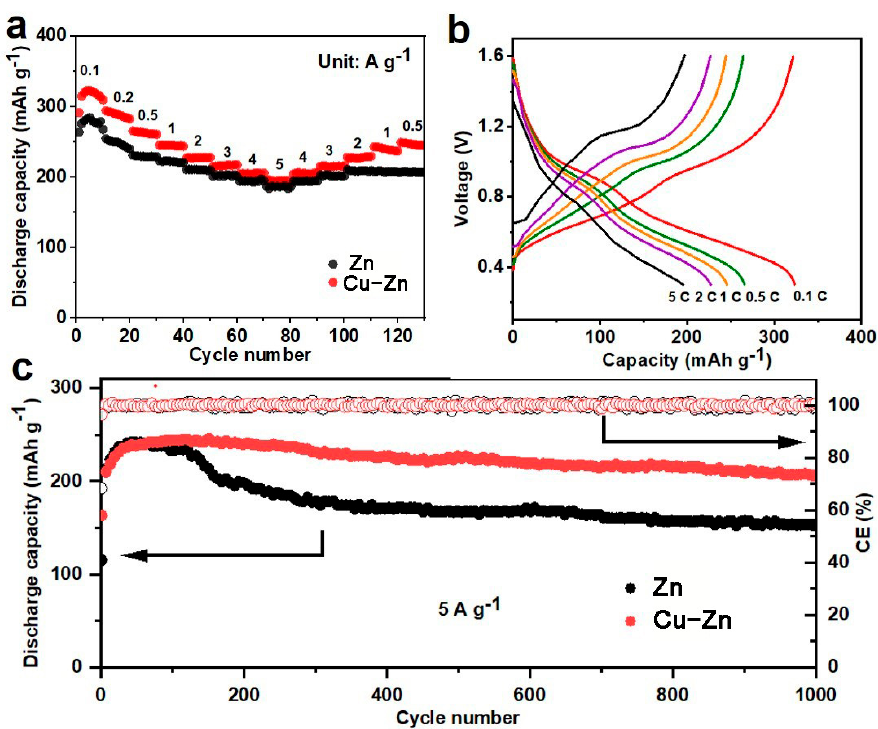
Figure 8. ( a ) Rate performance of V 2 O 5 -PEDOT//Zn and V 2 O 5 -PEDOT//Cu-Zn, ( b ) charge/discharge curves of V 2 O 5 -PEDOT//Cu–Zn at different current densities, ( c ) cycling performance of V 2 O 5 -PEDOT//Zn and V 2 O 5 -PEDOT//Cu–Zn at a current density of 5 A · g − 1 .